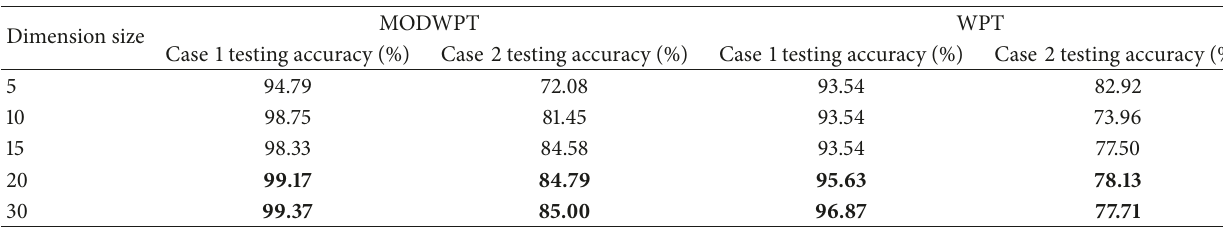
Table 4: Bearing fault diagnosis results obtained by OFS-PCA-SVM.